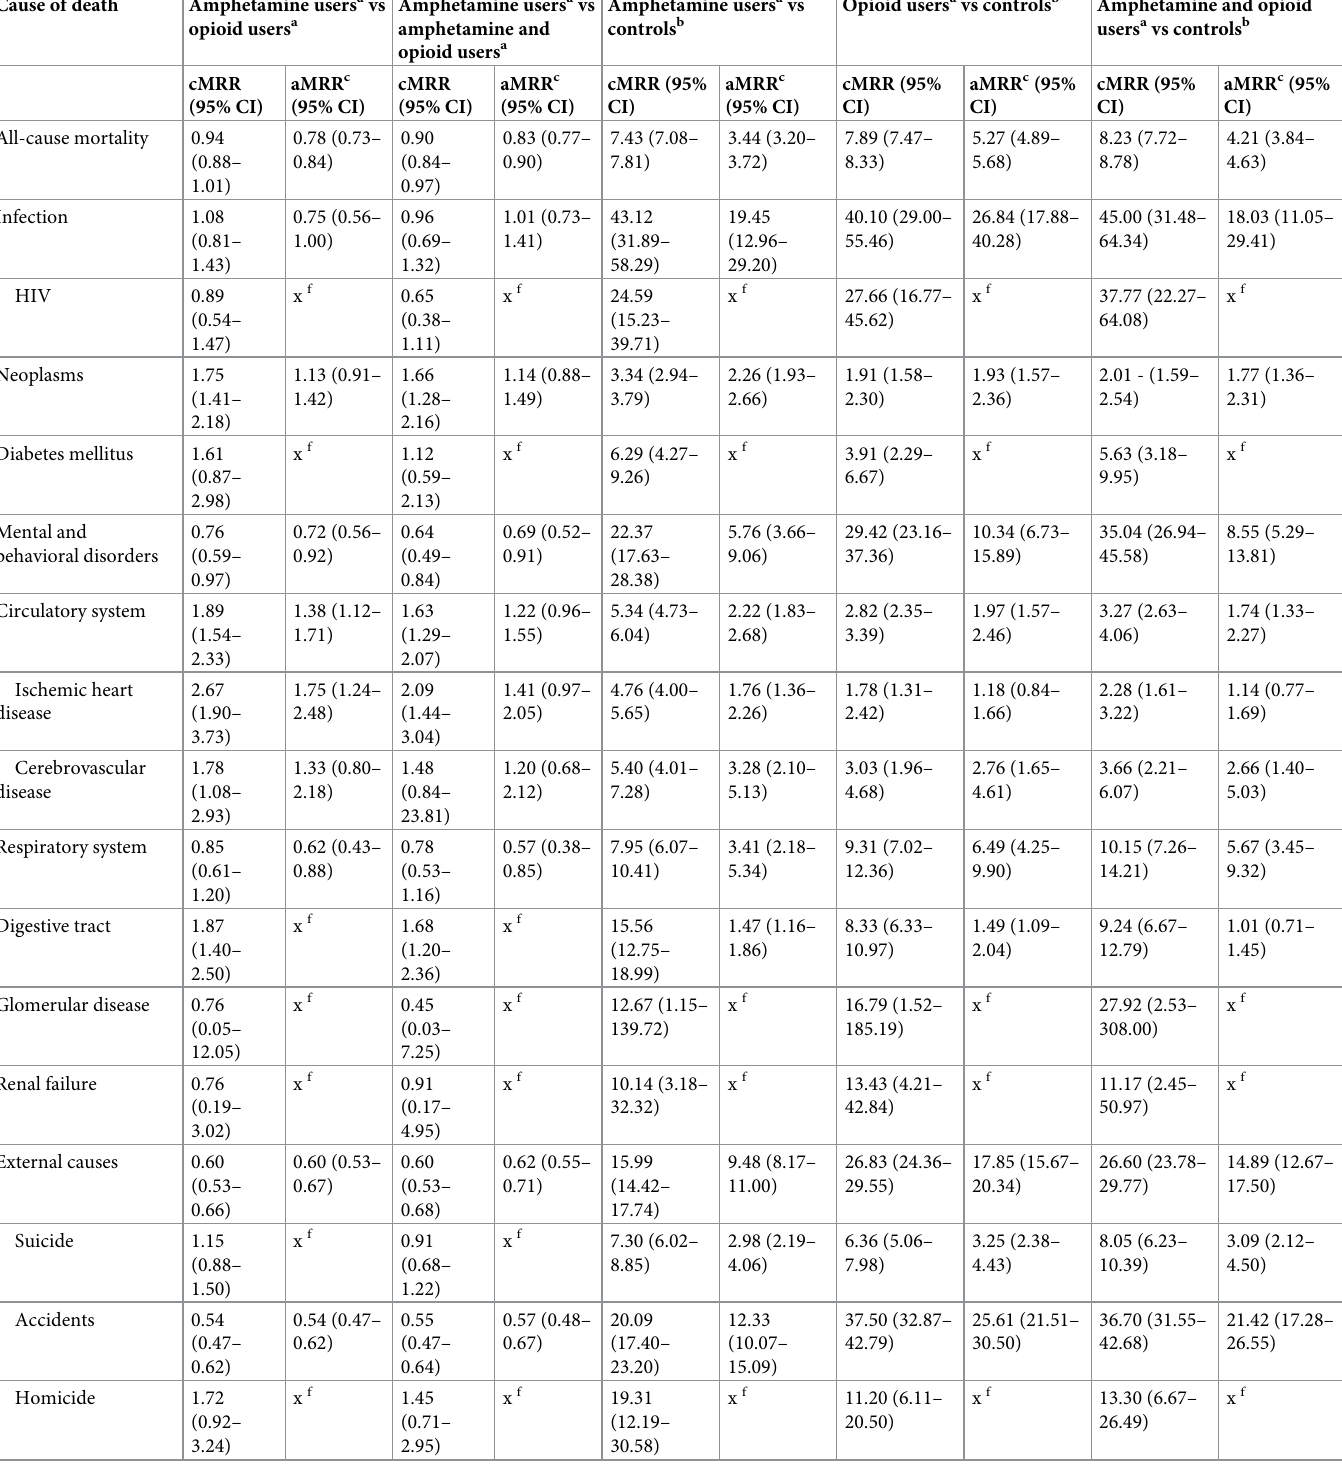
Table 3. Mortality rate